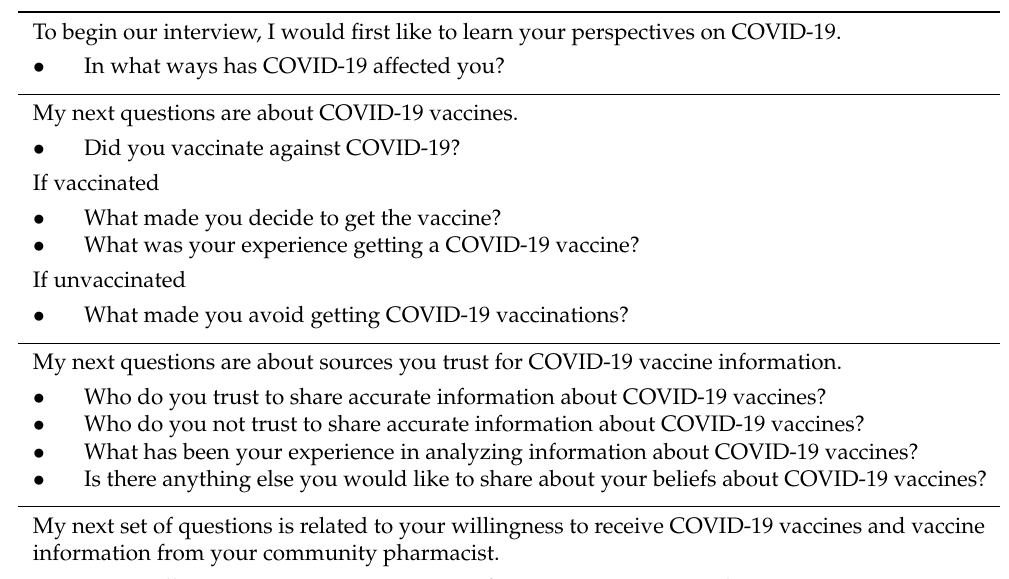
Table 1. Semi-structured interview